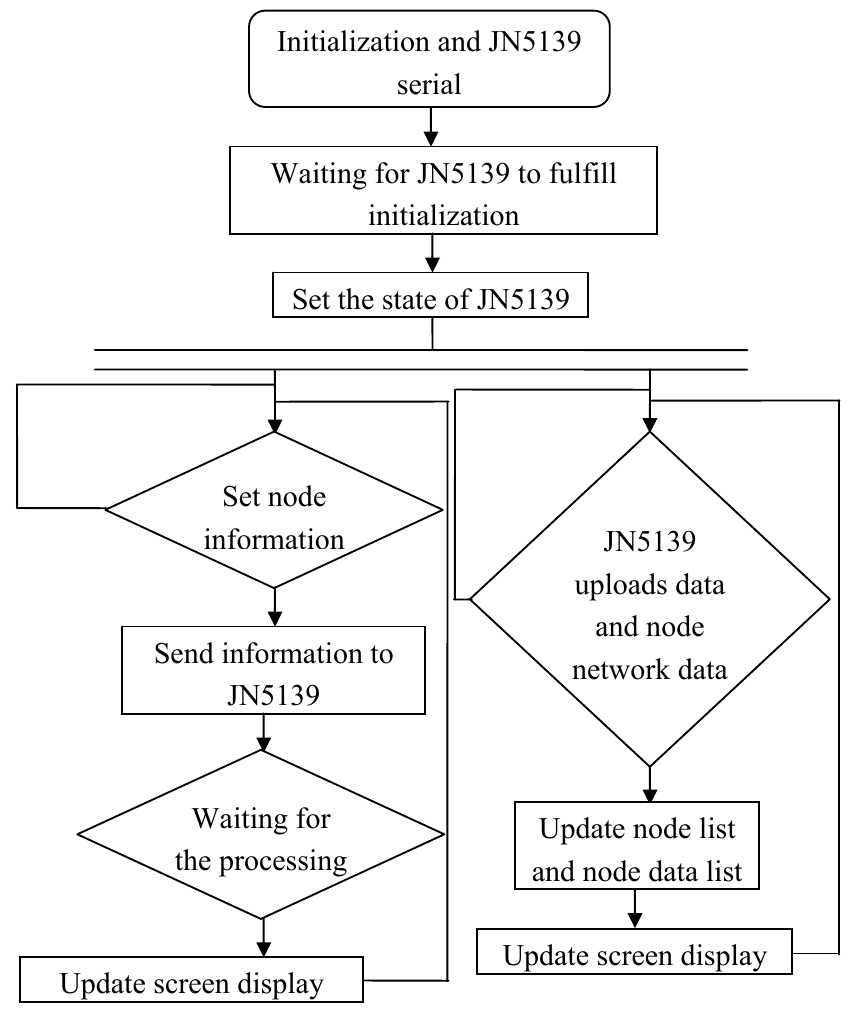
Figure 12. Interfacing implementation of LPC2138 and JN5139